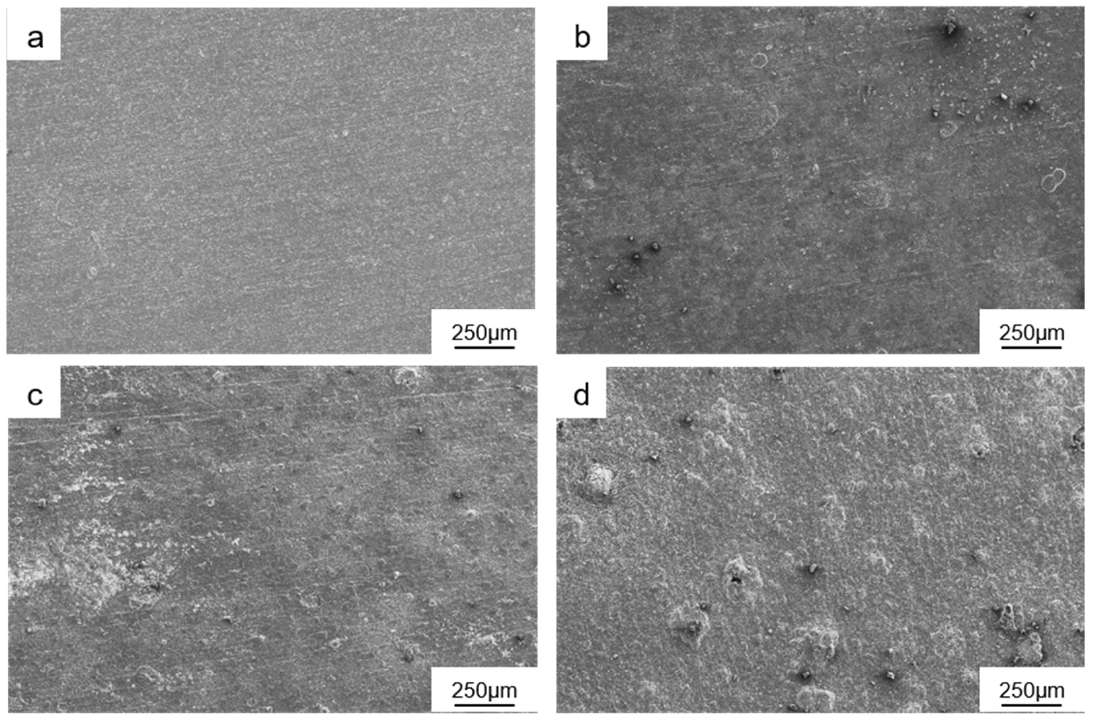
Figure 8. Surface morphology of Al-2Li-0.2Sc alloy after 5 h oxidation ( a ) 400 °C, ( b ) 450 °C, ( c ) 500 °C, ( d ) 550 °C.